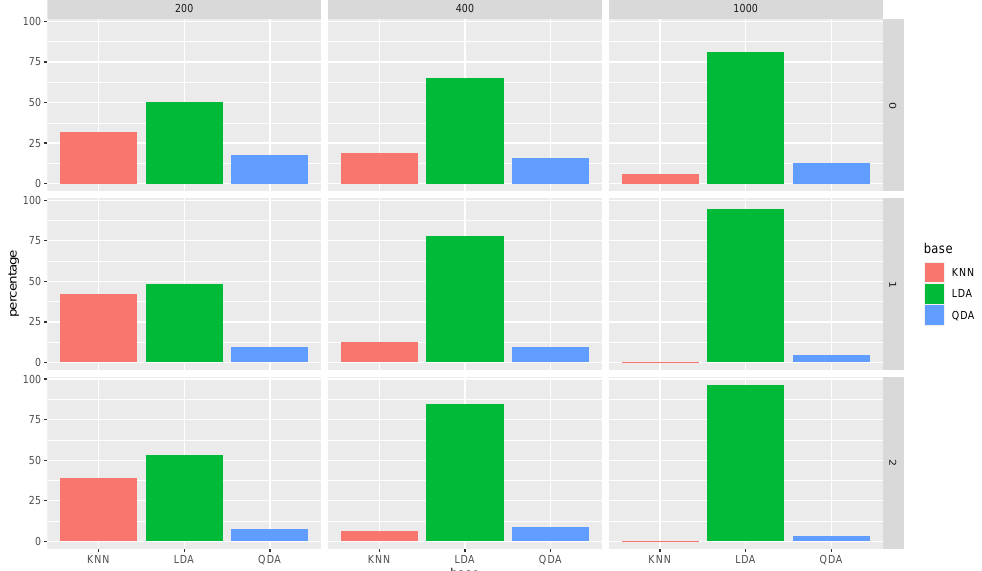
Figure 1. The average selected proportion for each base method for different sample sizes (corre- sponding to each column) and iteration number (corresponding to each row) in Model 1 (LDA).